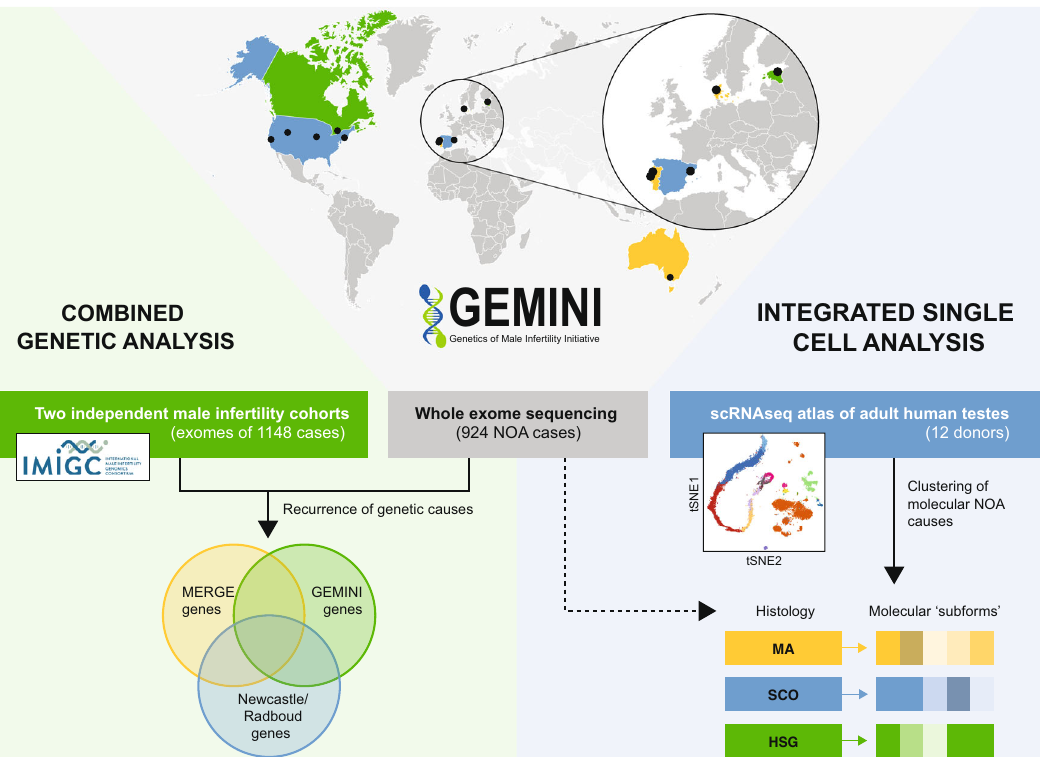
Fig.1|Overviewofthestudy. DNAsamplesfromNOAcasesrecruitedin11centers across the world underwent WES to detect rare recessive variants underlying the disease. The identi fi ed Mendelian causes of NOA were additionally screened for in independentmaleinfertilitycohortstomaprecurrentcausesofNOA.Anintegrated